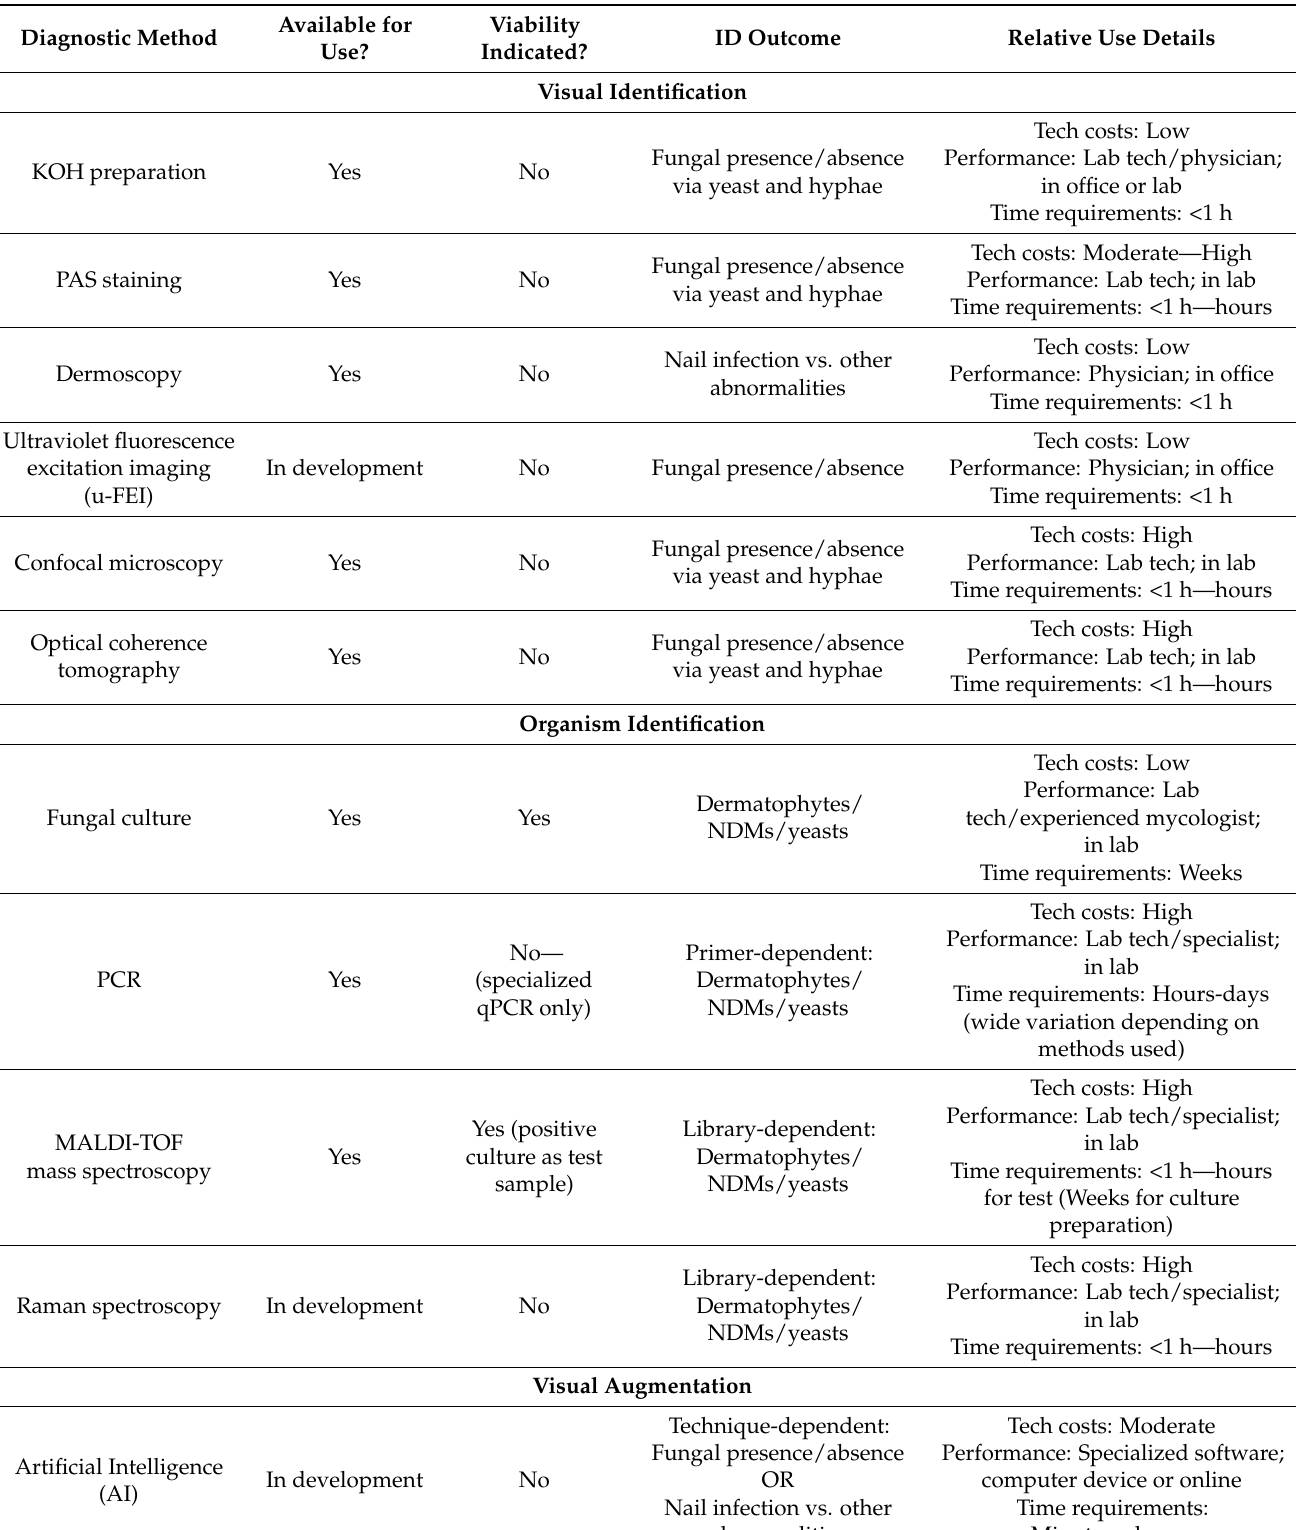
Table 1. Summary of Diagnostic Methods for